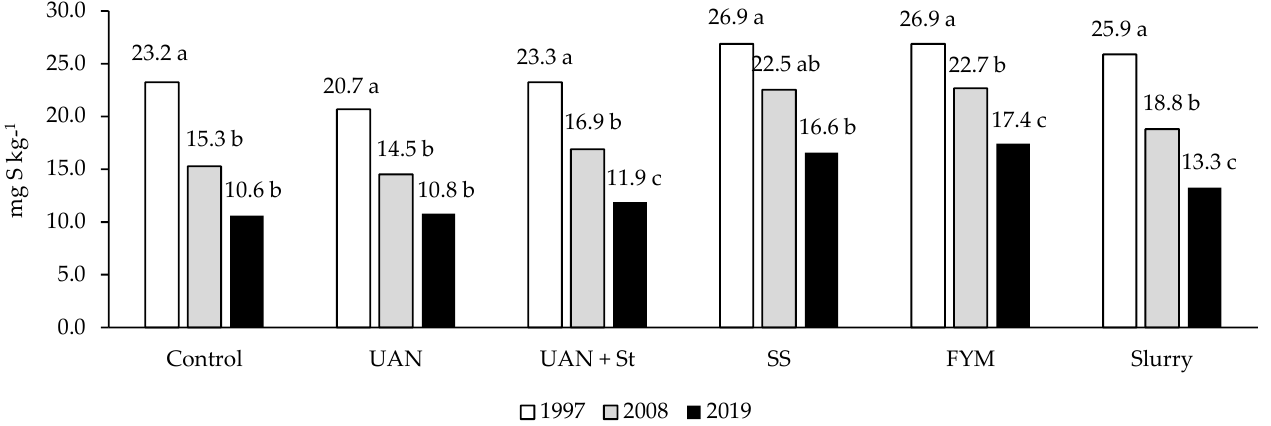
Figure 6. Content of Mehlich 3 extractable sulfur fraction (S M3 ) in topsoil. Different letters describe significant differences between years within the treatment. Tukey HSD test ( p < 0.05), ( n = 4). The significantly decreasing soil sulfur pools were found even in the S pt (Figure 7) fraction with few exceptions. Firstly, although the SS treatment showed a decreasing trend, due to variability in results, the decrease was insignificant. Given several more years, the situation would be likely to change. The second exception was the FYM treat- ment, which produced insignificant changes. The FYM and SS treatments had, in general ,